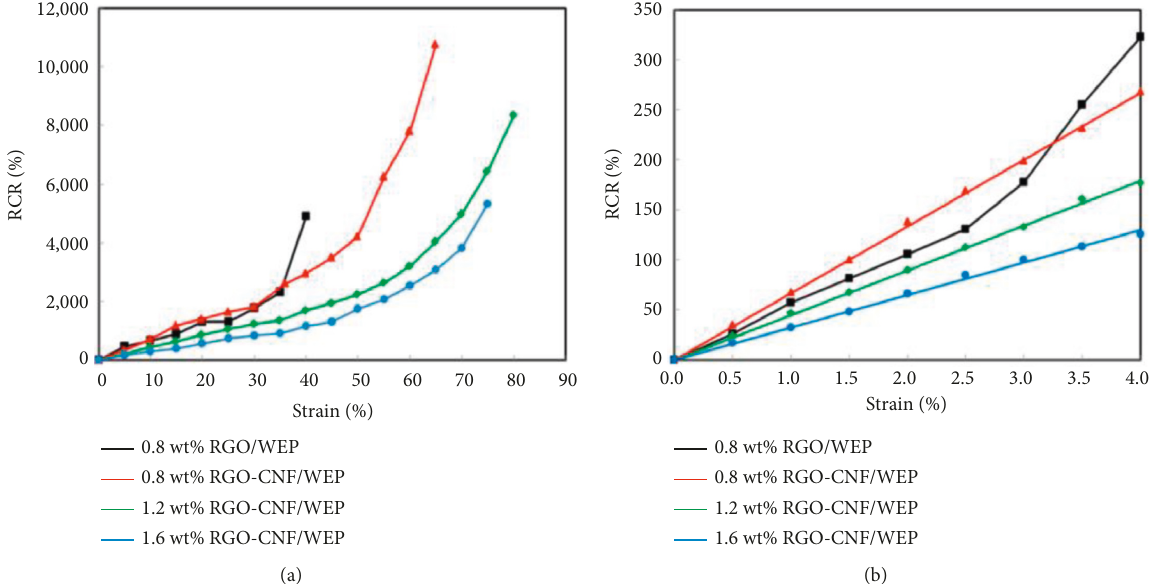
Figure 21: (a) The correlation of the RCR and strain. (b) The correlation of RCR and strain within a 4% strain range [108].